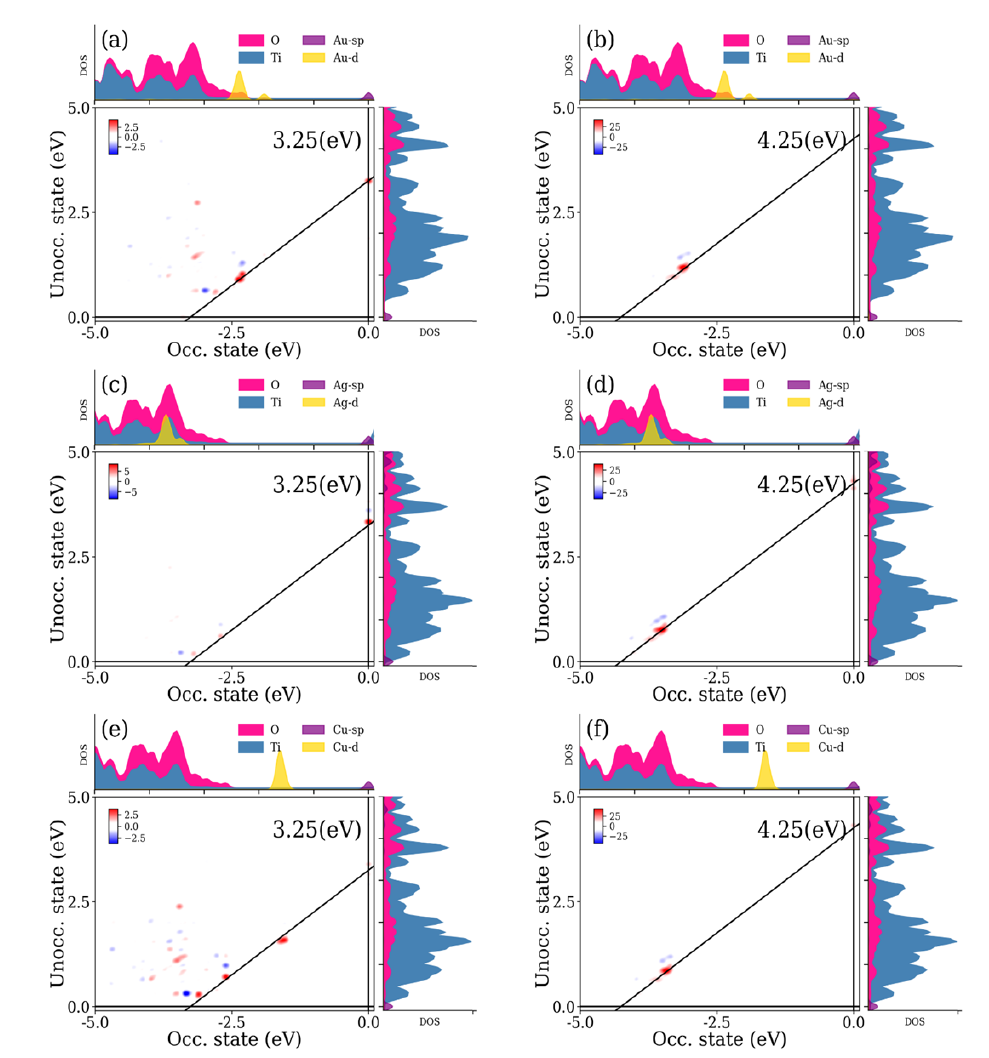
Figure 6. TCM of deposited Au (first row ( a , b )), Ag (second row ( c , d )), and Cu (third row ( e , f )) Me s for the bonded Me s for 3.25 eV ( a , c , e ) and 4.25 eV ( b , d , f ) at p6 position. The diagonal solid lines are used to emphasize the constant transition